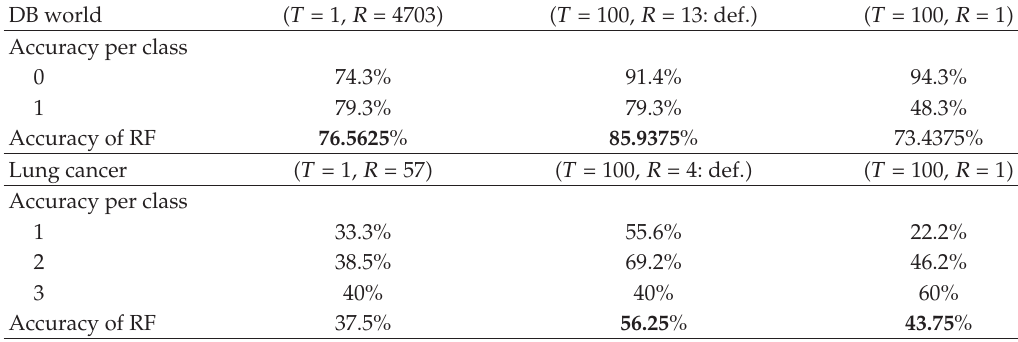
Table 13 has the results of experiments for the dataset “DB world.” Table 14 has the results of experiments for the dataset “lung